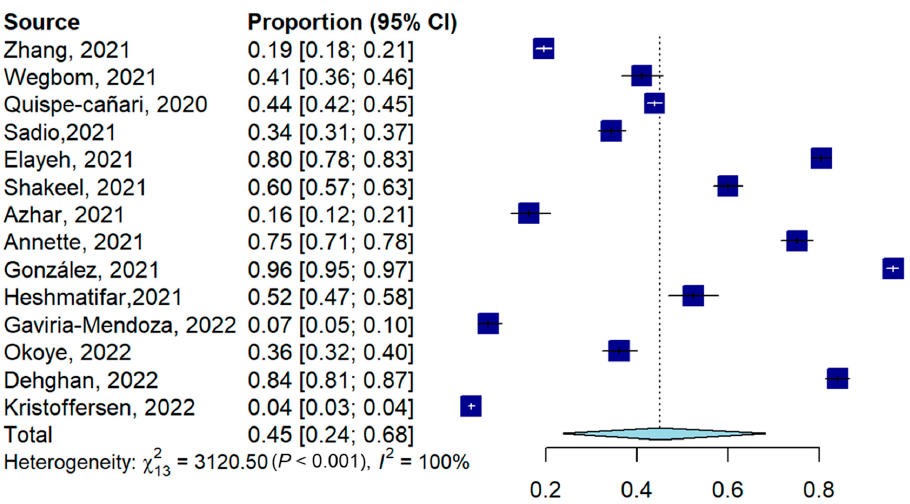
Figure 2. Forest plot for the pooled prevalence of COVID-19-related self-medication [6,11,12,18–28].